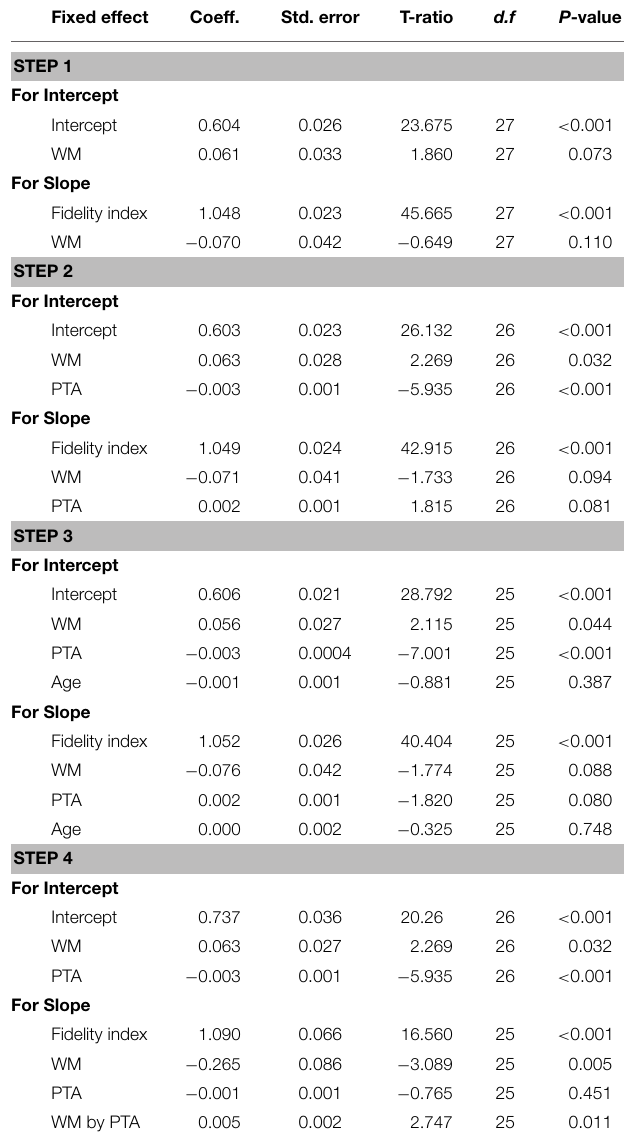
TABLE 2 | Summary of hierarchical linear model for intelligibility with working memory capacity (WM) as a